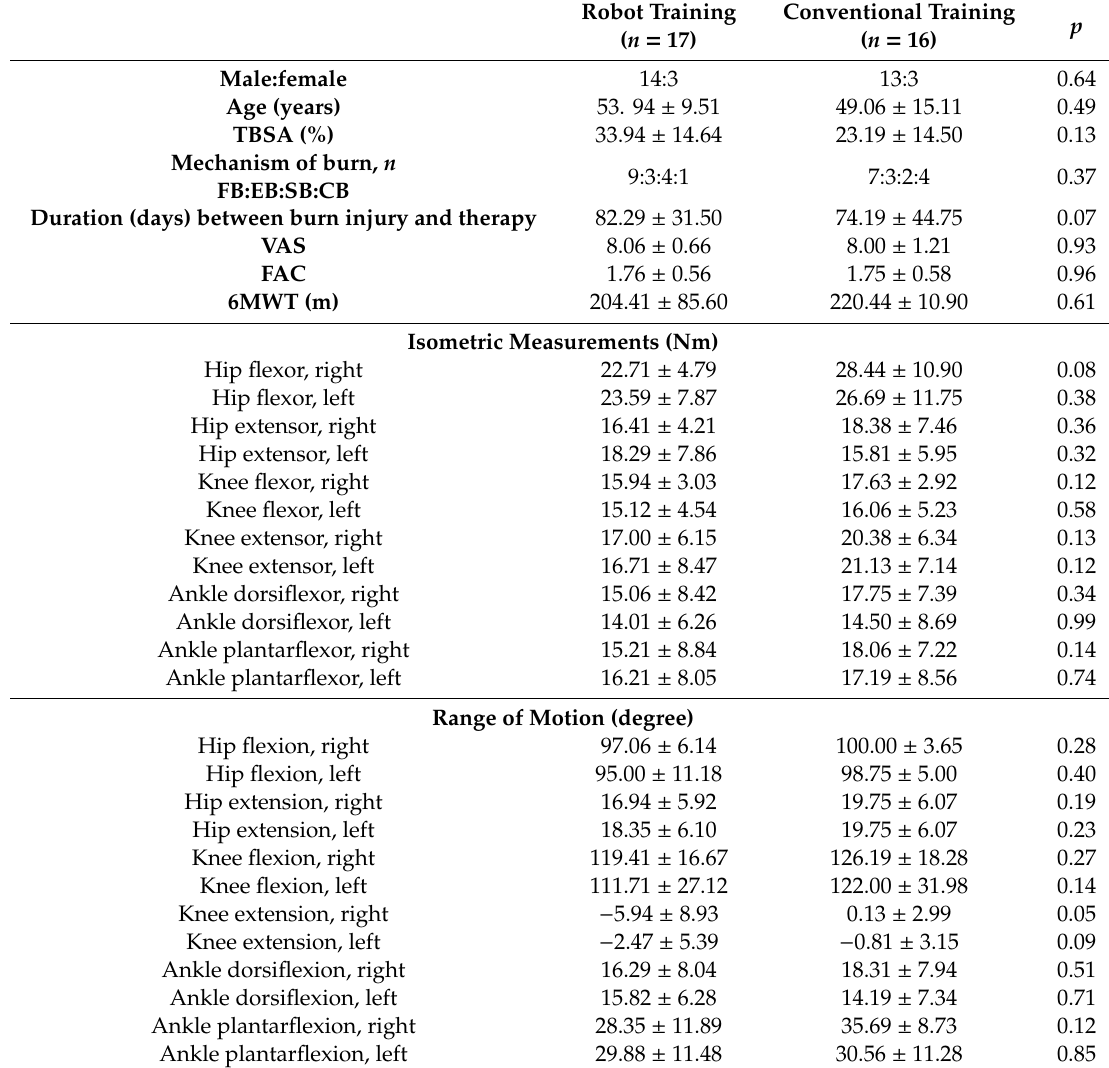
Table 1. Patients’ demographic data.